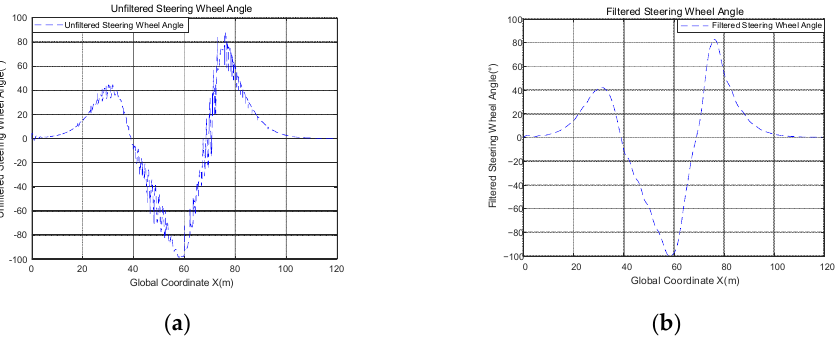
Figure 5. Steering wheel angle before and after filtering. ( a ) Unfiltered steering wheel Angle; ( b ) filtered steering wheel angle.